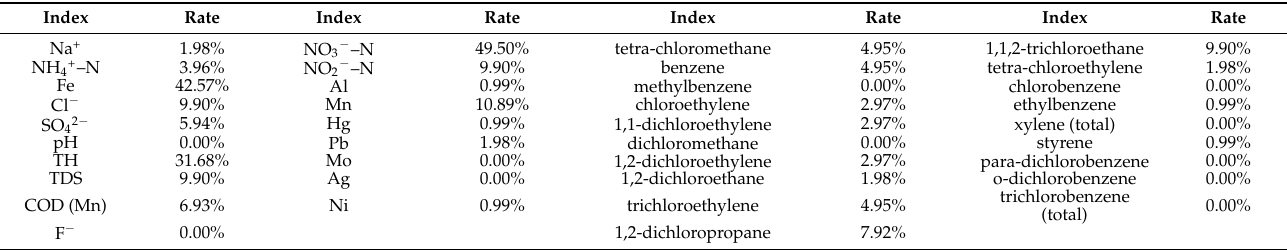
Table 2. Exceeding rate of the index